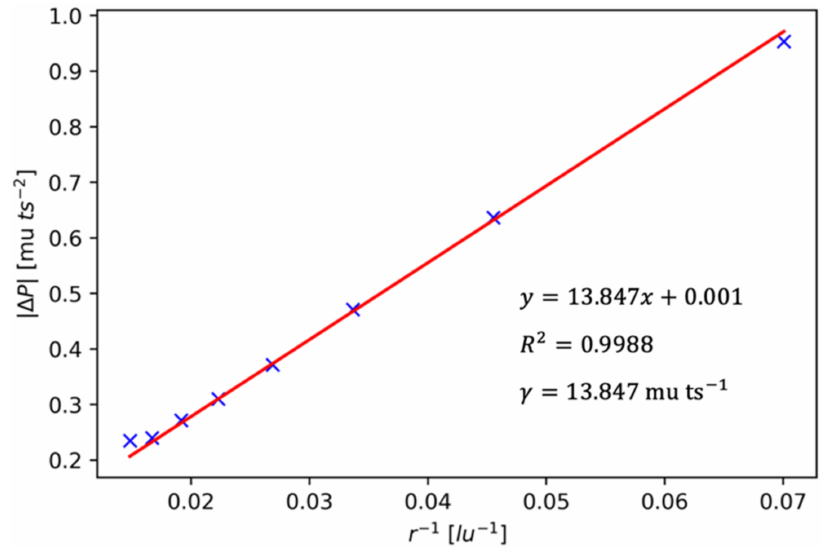
Figure A1. Correlation between pressure difference ( ∆ p ) between inside and outside the bubble and reciprocal of its equilibrium radius